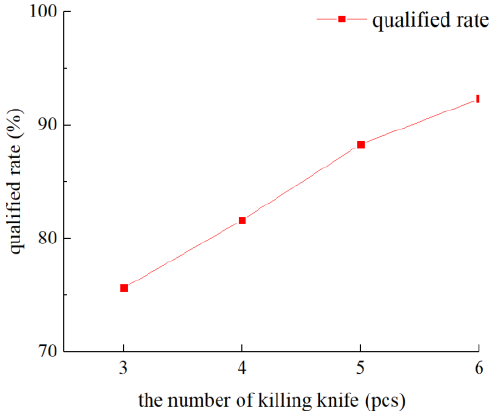
Figure 11. Curve of qualified rate of broken sweet potato vines with the number of killing knifes.